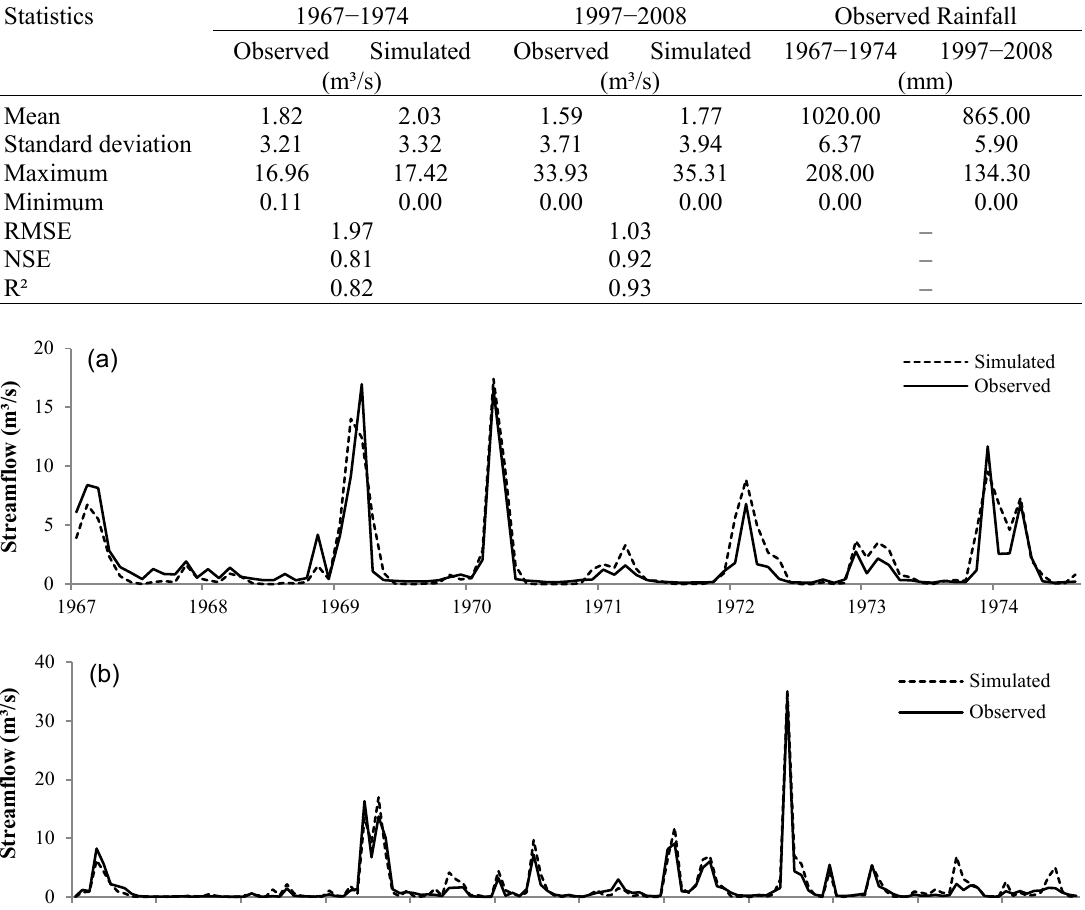
Table 1 Descriptive statistics of measured and simulated monthly streamflow in the Tapacurá catchment .